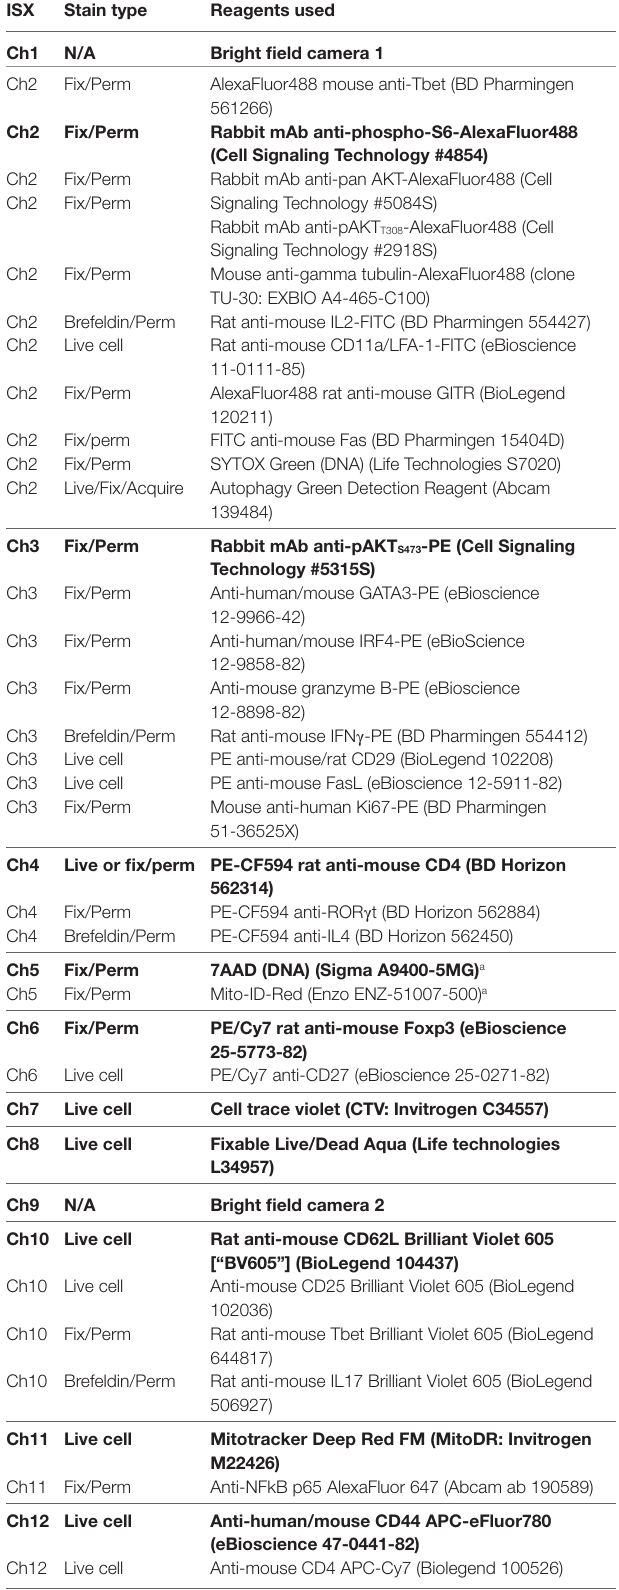
Table 1 | Fluorescent reagents for imaging flow